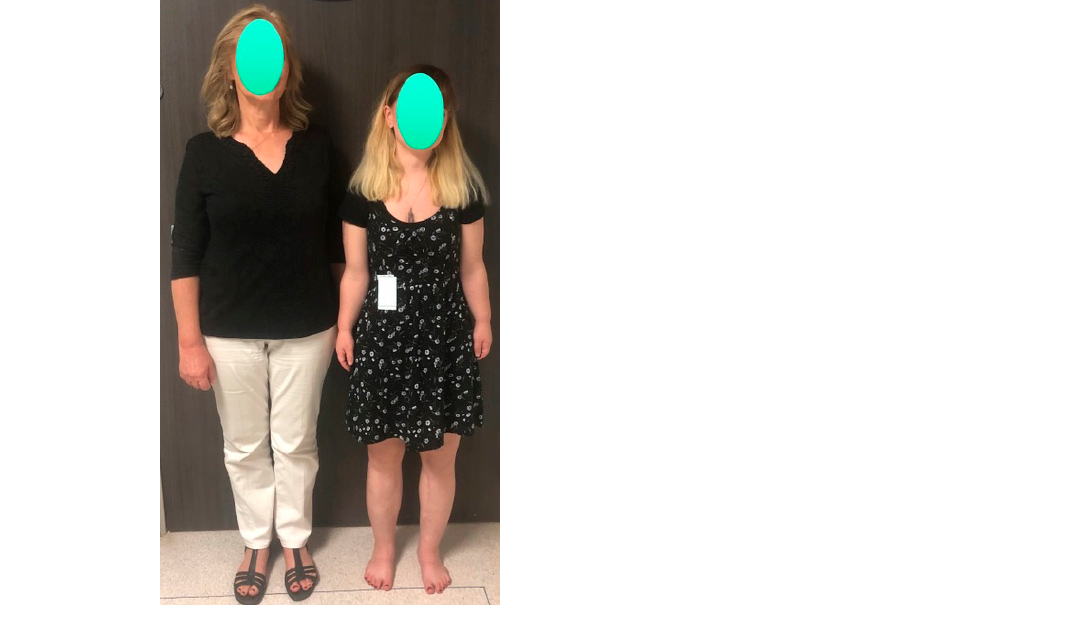
Figure 7. Same patient as in Figures 4–6 standing next to her mother at the age of 28. She began the juvenile-onset ELL at age 7 years. The patient is 5 ′ 2 ″ compared to her mother who is 5 ′ 9 ″ .